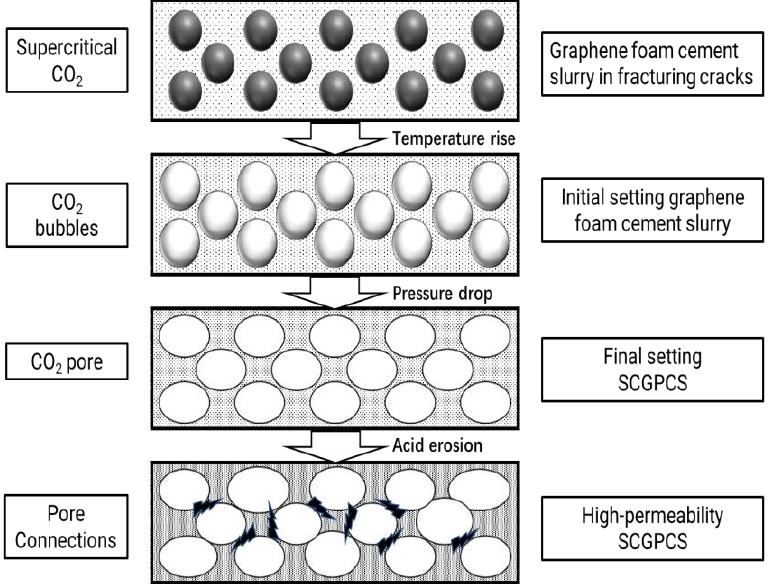
Figure 24. Mechanism diagram of graphene – foam – cement slurry forming high permeability